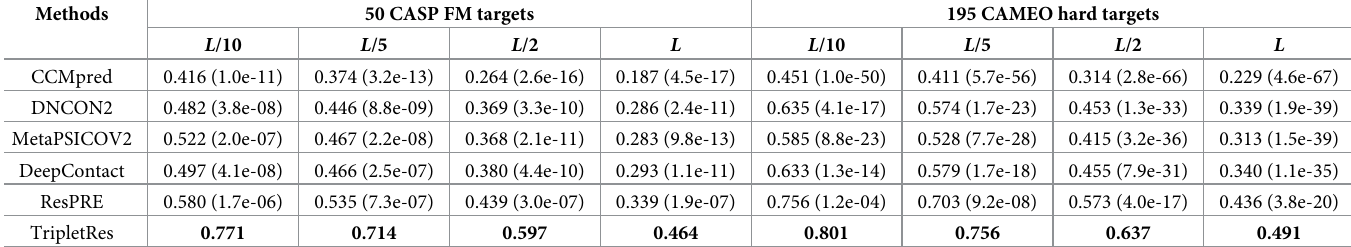
Table 1. Summary of long-range contact precision by TripletRes and control methods on 50 CASP11&12 FM targets and 195 CAMEO hard targets, sorted in ascending order of top- L precision. p -values in parenthesis are from a Student’s t-test between TripletRes and each of the control methods, where bold fonts highlight the best performer in each